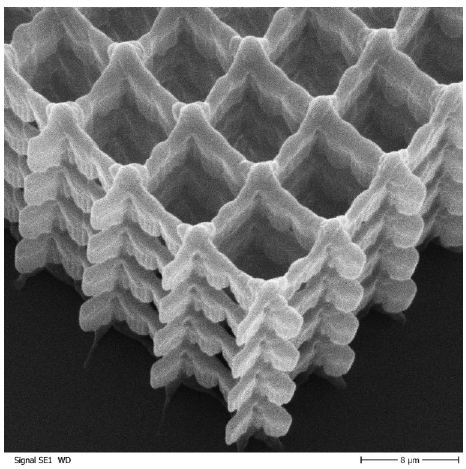
Figure 5. Structure with 90nm layer height